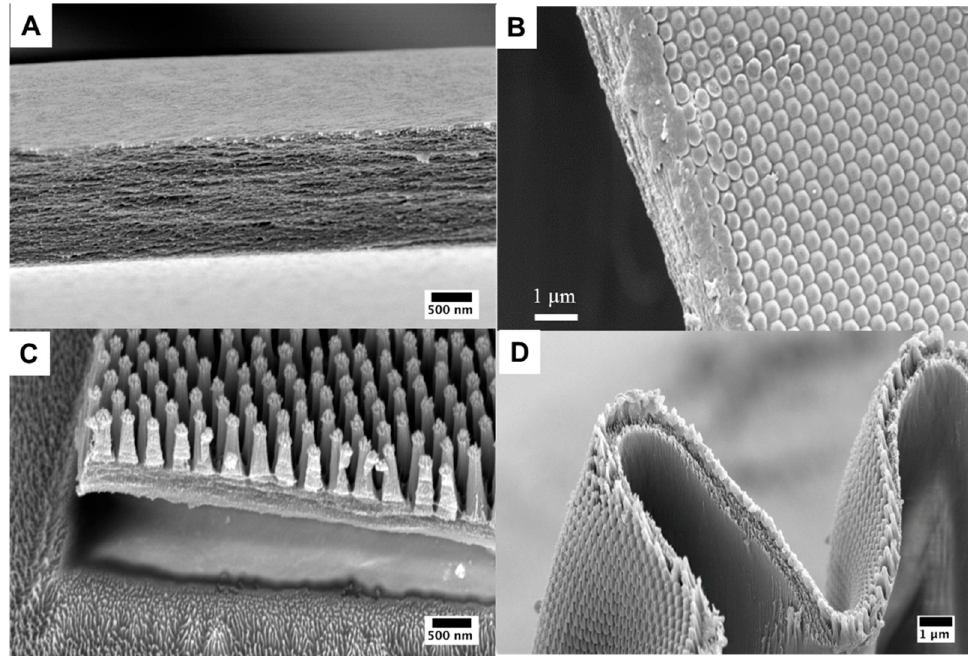
Figure 4. Colloidal/nanosphere lithography on drop-cast chitosan thin films. ( A ) A drop-cast chitosan thin film; note the layers of chitosan nanoscale fibers; ( B ) 300 nm nanosphere mask on chitosan thin film—note the distortion of the polystyrene nanospheres as they are stretched across the surface of the chitosan substrate; ( C ) Post-reactive ion etch of a nanosphere-masked chitosan substrate—note the high-aspect ratio nanocone arrays; ( D ) Flexible nanostructured chitosan thin film.